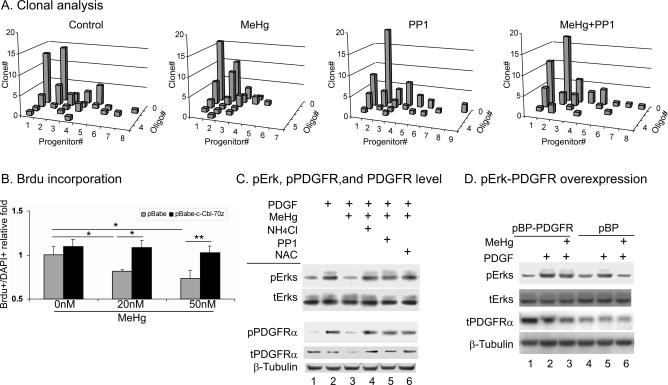
Inhibition of Fyn Activity, c-Cbl Activity, or of Lysosomal Function Rescues Cell Division and/or ERK1/2 Phosphorylation in MeHg-Treated O-2A/OPCs(A) Purified O-2A/OPCs were plated at clonal density and analyzed as for Figure 2. After 24 h, MeHg was added to cultures in the presence or absence of PP1. MeHg by itself was associated with a reduction in the contribution of large clones dominated by progenitors and an increased representation of smaller clones and of oligodendrocytes. Co-exposure to PP1 rescued cells from the effects of MeHg.(B) Expression of DN(70Z) c-Cbl rescued purified progenitors from MeHg-associated suppression of BrdU incorporation. It was notable that expression of DN(70Z) c-Cbl also rescued cells from the effects of 50 nM MeHg, raising the possibility that further exploration of this pathway will reveal additional roles in cell survival (a topic to be explored in future research). *, p < 0.05; **, p < 0.01.(C) Co-exposure of cells to NH4Cl or PP1 together with MeHg protected cells from MeHg-induced suppression of ERK1/2 and PDGFRα phosphorylation and reductions in total levels of PDGFRα.(D) Overexpression of PDGFRα also rescued cells from MeHg-induced suppression of ERK1/2 phosphorylation, whereas expression of a control construct (pBP) did not rescue ERK1/2 phosphorylation.All experiments were repeated at least three times, and all numerical values represent means ± SD for triplicate data points. The plus symbol (+) indicates exposure of the cells to the indicated substance.